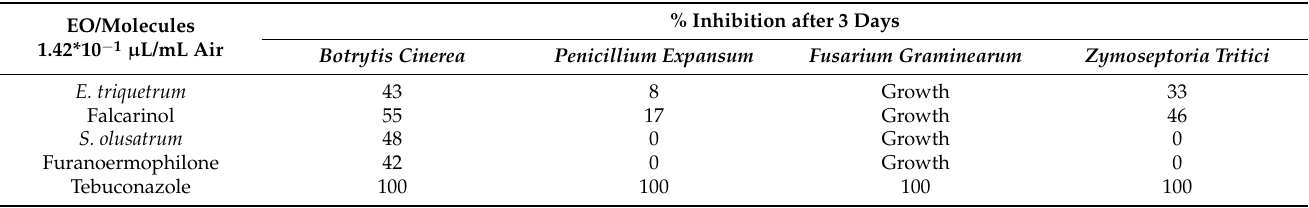
Table 8. Fumigant antifungal activity of E. triquetrum and S. olusatrum essential oils and the major